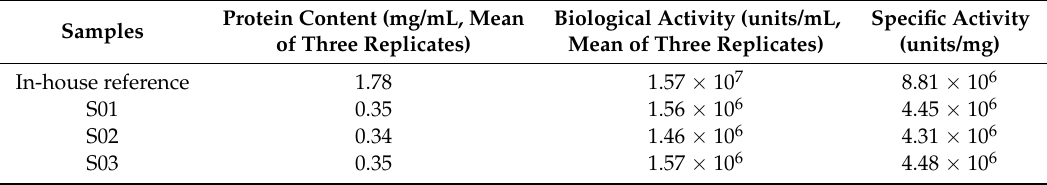
Figure 4. Dose-response curves of WHO biological standard for rhIL-12, the rhIL-12 in-house reference and rhIL-12 samples (S01–S03). Each plot represents the mean of two replicates. Table 3. The results of protein content, biological activity and specific